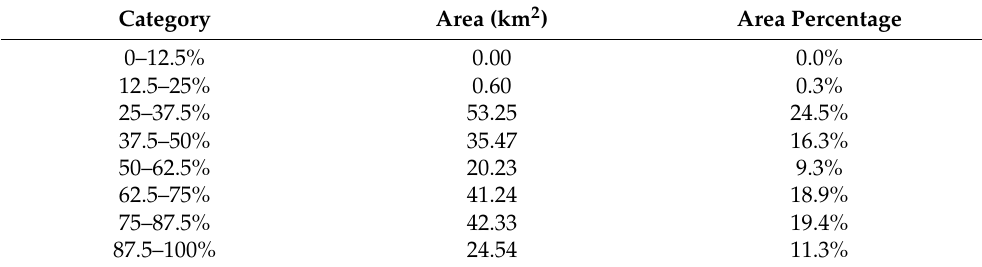
Figure 5. Classification of spatial flooding based on flooding frequency. Table 2. Flooded area covered for the frequency of occurrence of each